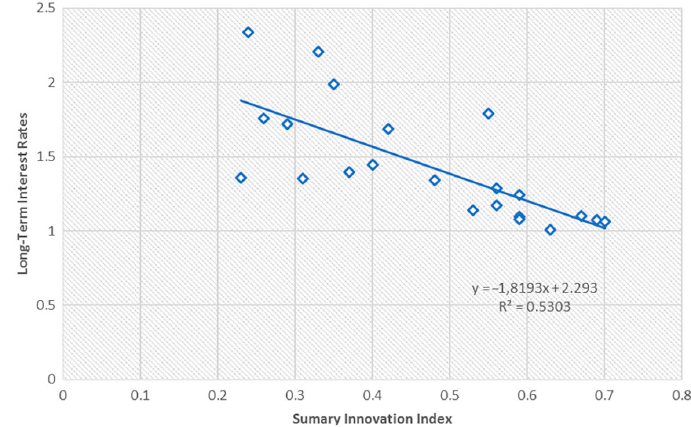
Figure 1. Relationship between innovation and financial capabilities for the entire sample in 2010